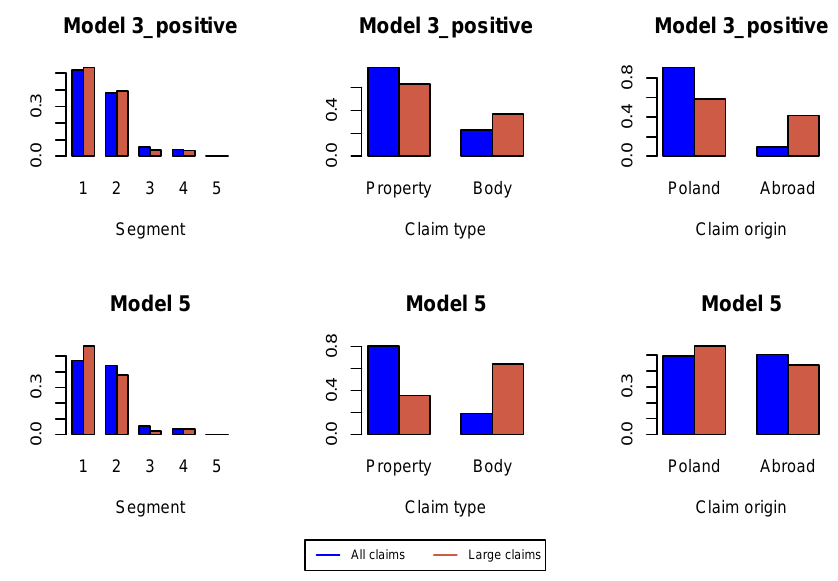
Figure A2. Proportions of claim features in the whole data set and in the data set of large claims in k = 2.